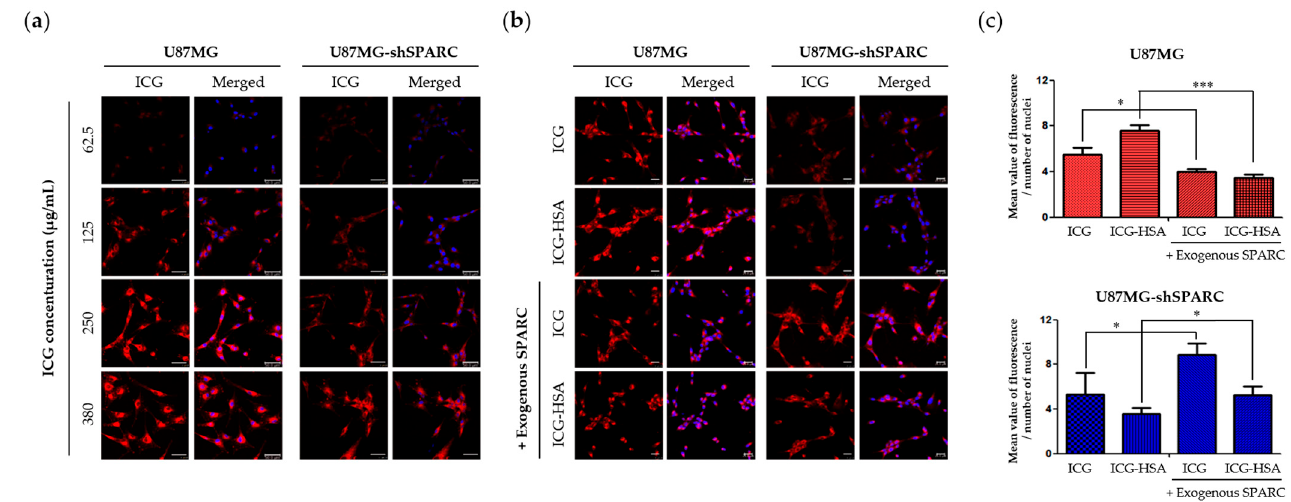
Figure 2. In vitro fluorescence imaging of ICG-HSA complex in U87MG and U87MG-shSPARC cell lines. ( a ) Fluorescence images of U87MG and U87MG-shSPARC cells after incubation with different concentrations of ICG, respectively. Scale bars, 25 μ m; ( b ) fluorescence images of U87MG and U87MG-shSPARC cells after incubation with ICG or ICG-HSA complex. The ICG is red, and the DAPI-stained nuclei are blue. Scale bars, 50 μ m. ( c ) Quantifying ICG or ICG-HSA uptake in each cell type from confocal images *: p < 0.05, ***: p <0.001.